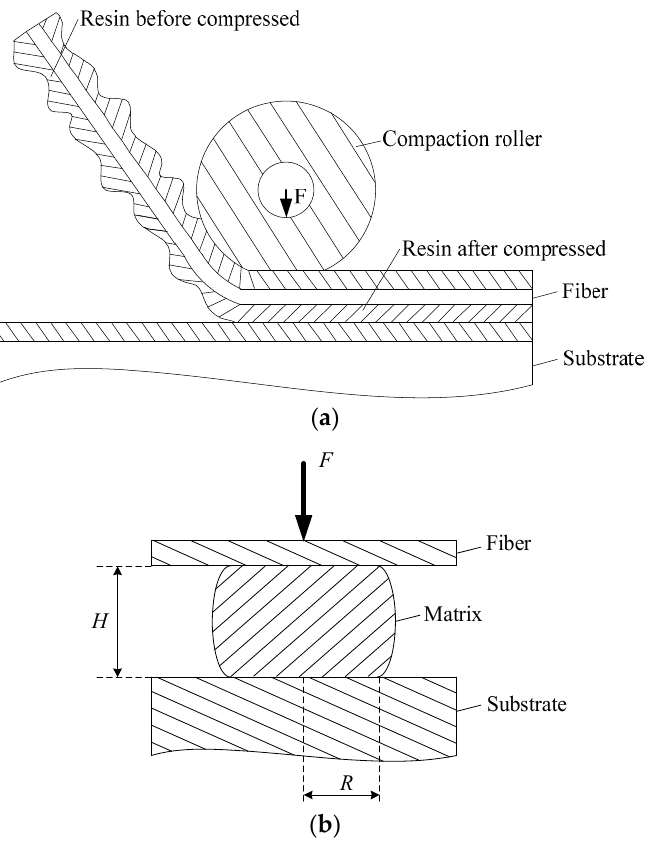
Figure 1. Squeezing flow of resin patch under parallel plate. ( a ) Interface between prepreg tow and the substrate surface. ( b ) The contact surface of the thermoset prepreg tow.